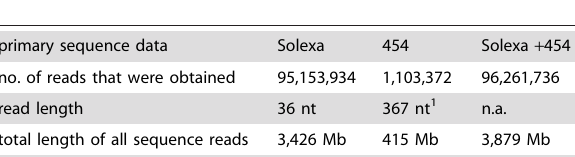
Table 1. Main features of primary sequence